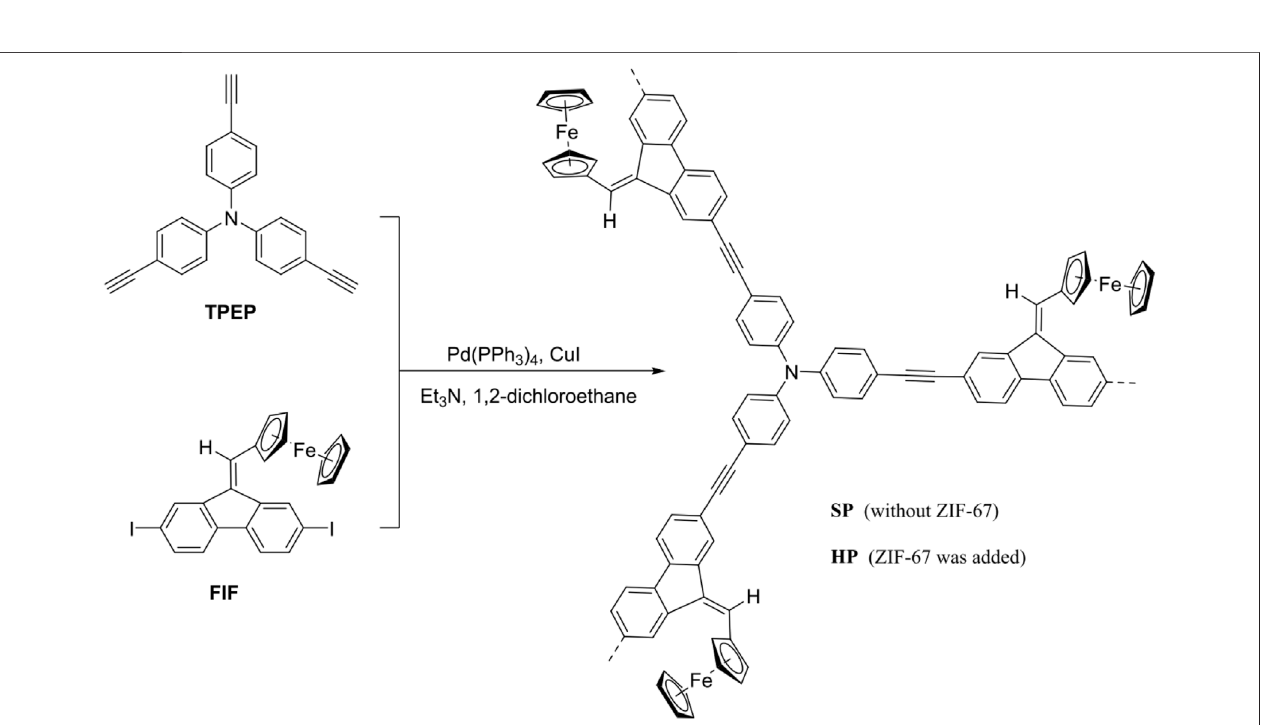
Frontiers in Energy Research |